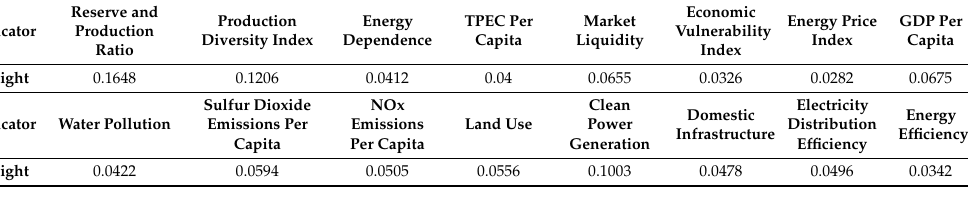
Table 6. Weights for each indicator of ESSI.